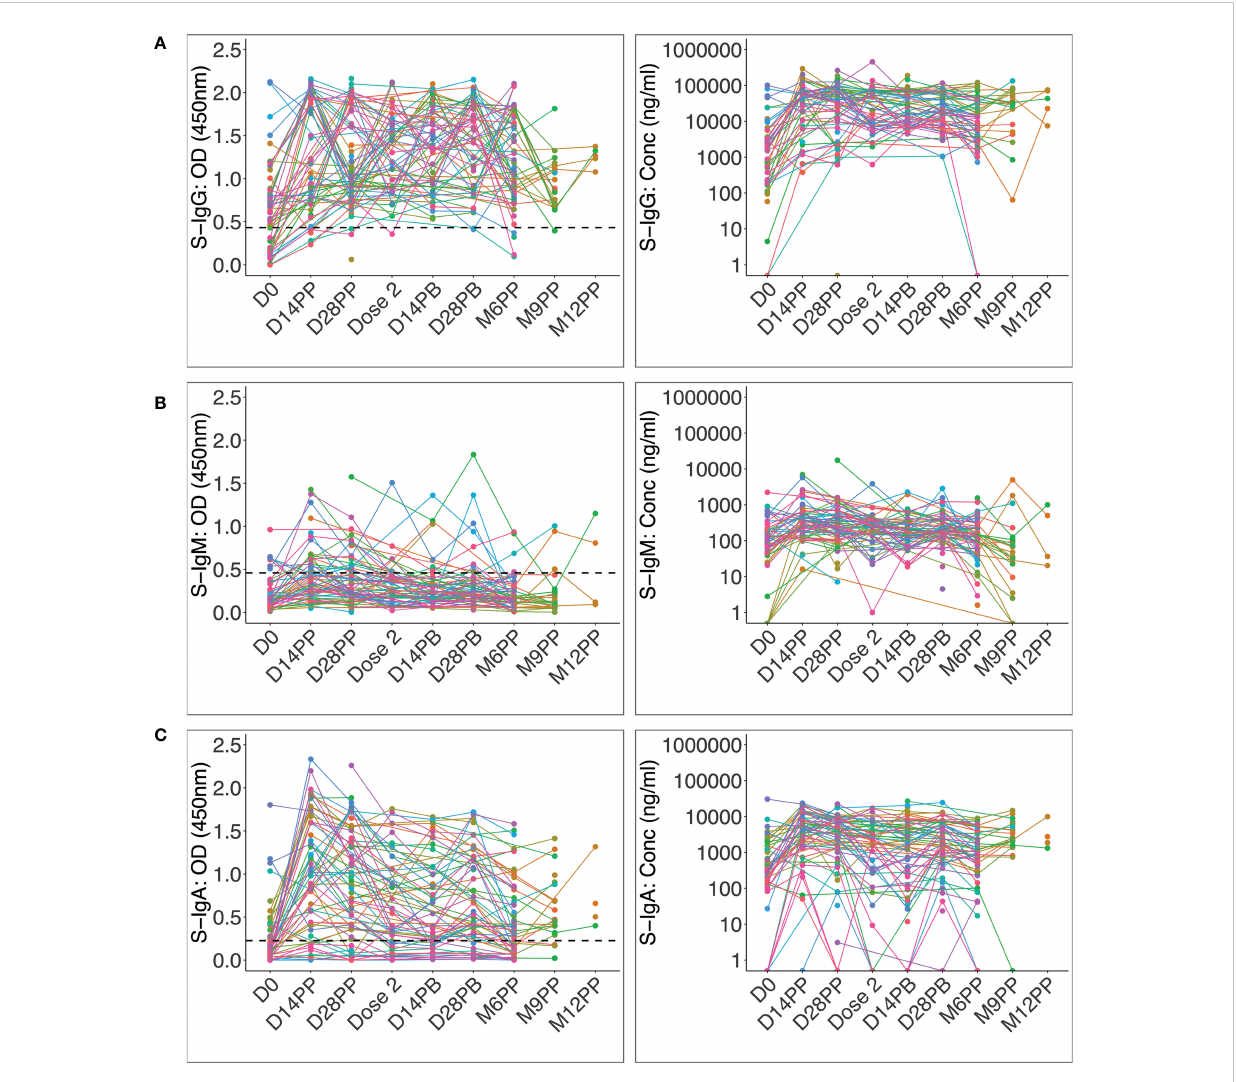
FIGURE 2 Individual pro fi le plots of spike-directed IgG, IgM and IgA antibody optical densities and concentrations after vaccination. Figure 2 shows the individual pro fi le plots of spike-directed IgG (A) , IgM (B) , and IgA (C) antibody OD values (nm) and concentrations (ng/ml) over 12 months since the initial vaccination of individuals previously infected with mild or asymptomatic COVID-19. The dashed horizontal lines represent the cut-off points for antibody OD value seropositivity. The cut-offs for spike-directed IgG, IgM, and IgA seropositivity were 0.432, 0.459 and 0.226,